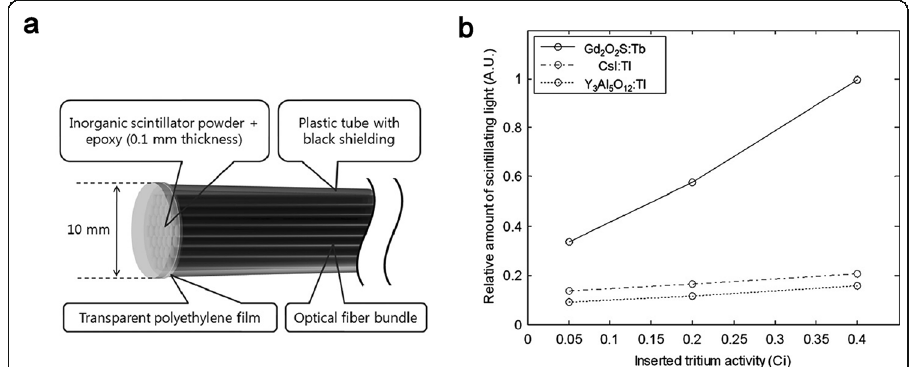
Fig. 4 IOSFD for detection of tritium [51]. a A schematic diagram of sensor tip. b Measured amounts